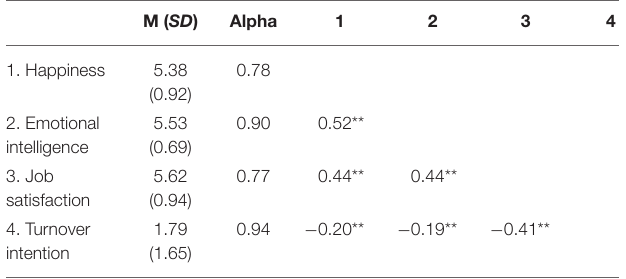
TABLE 1 | Descriptive statistics and bivariate correlations.